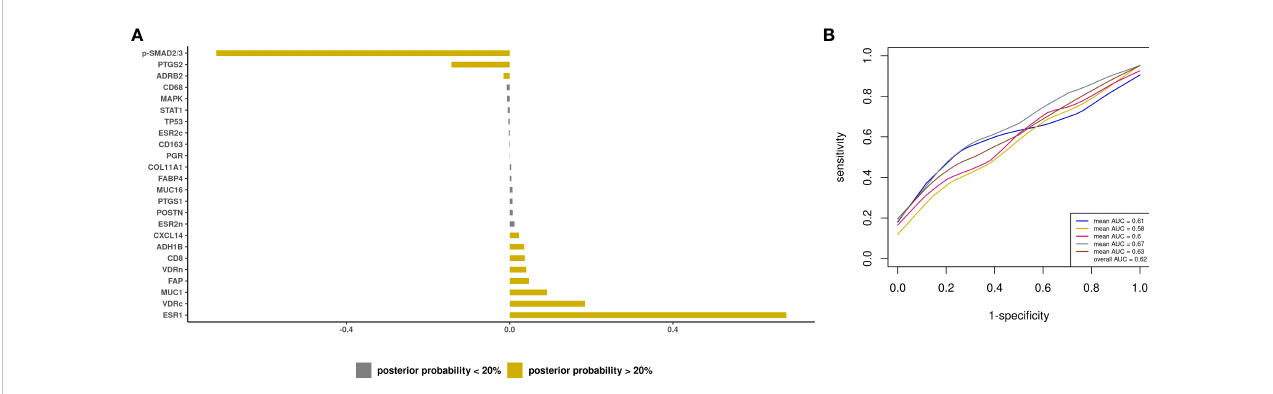
FIGURE 4 Prediction modeling of optimal debulking status using tissue markers. Average posterior means and associated average posterior probabilities of tissue markers being selected in the fi nal prediction model of optimal debulking status and area under the curve (AUC) of the prediction models using Bayesian model averaging among invasive epithelial ovarian cancer cases (n=166) in NHS/NHSII/NEC. We assessed the posterior probability of 24 tissue marker predictors for possible selection in the fi nal model and conducted fi ve 5-fold cross-validations. The bar chart (A) presents the average posterior mean across the 25 models that were run in total; grey bars denote predictors with average posterior probabilities <20% and yellow bars denote predictors with average posterior probability ≥ 20%. (B) presents the fi ve average AUCs from the fi ve 5-fold cross-validations and in the legend overall AUC, which is the average of the average AUCs from the 5-fold CV, is presented.